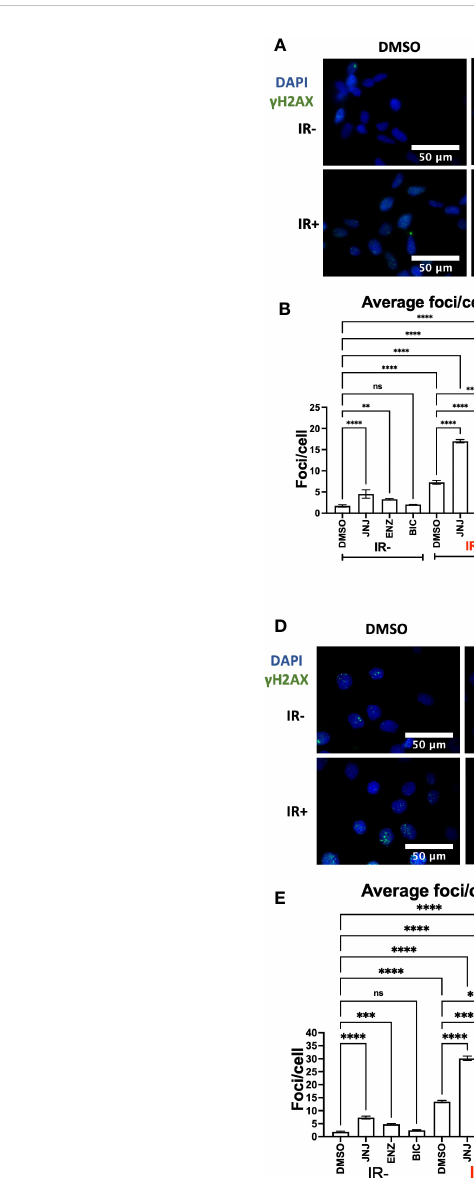
Morphological analyses further con fi rmed FIR-induced NED targeting by JNJ-64619178 treatment as evidenced by the changes in thepercentageofcellswithNE-likemorphologyaftertreatmentduring differentphasesofFIRtreatmentinbothLNCaP(neurites2xcellbody) (Figure6C)andDU145cells( ≥ 3neurites&neuritelengthtwicethecell body) (Figures 6F, G). Therefore, JNJ-64619178 can signi fi cantly inhibit FIR-induced NED and radiosensitizes prostate cancer cells.